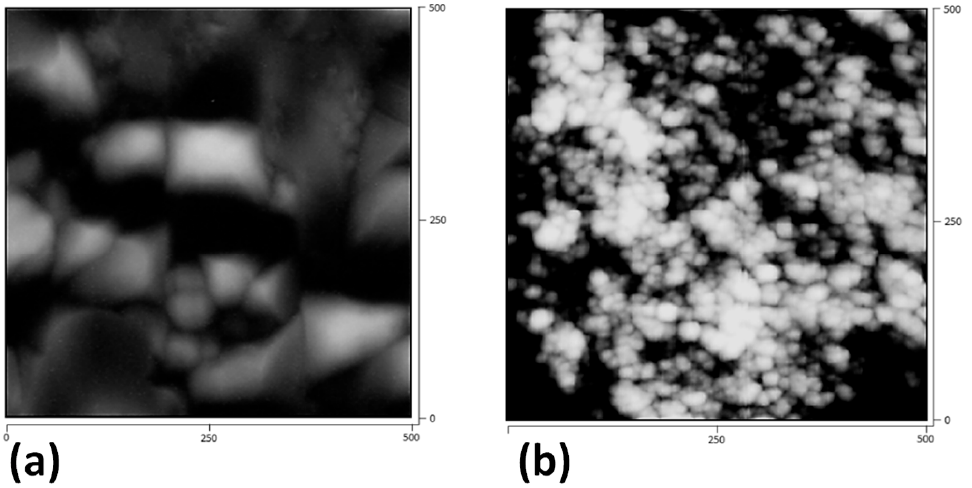
Figure 6. AFM images showing the microstructure of ( a ) SiO 2 /PCL 6 wt.% gel and ( b ) TiO 2 /PCL 6 wt.% gel. The numbers on the axis are in µm (micrometers).